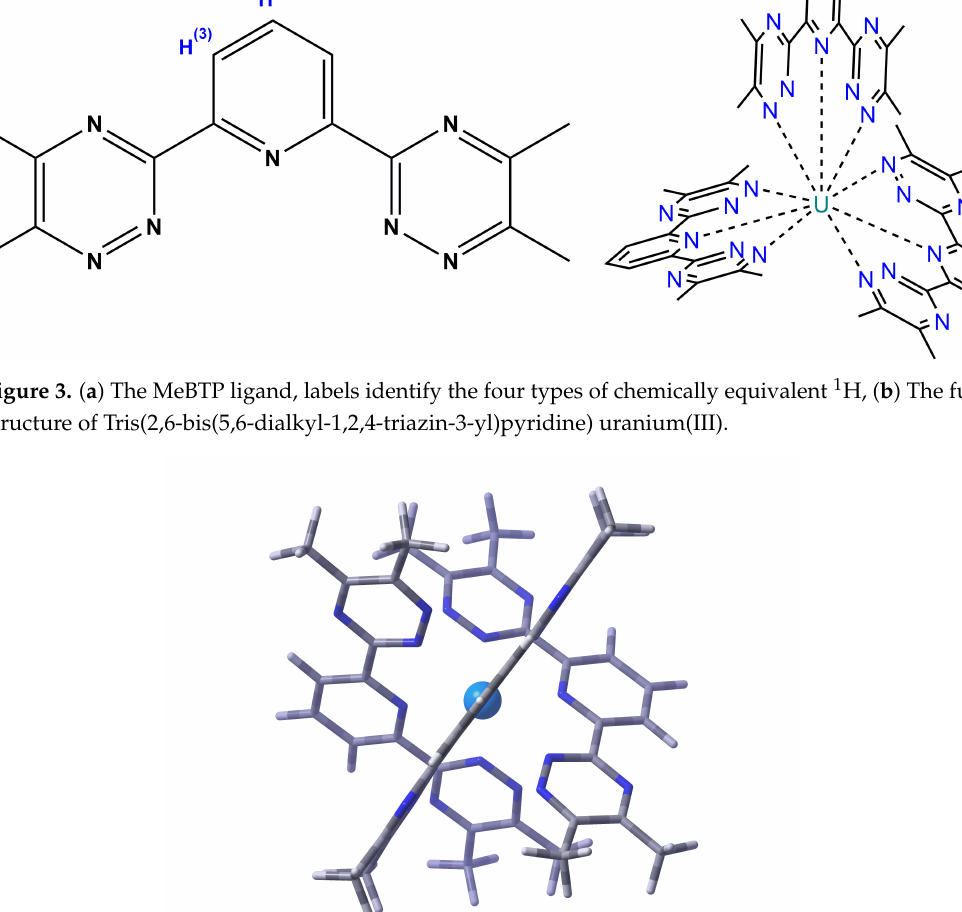
, showing the three planar ligands, staggered with 3